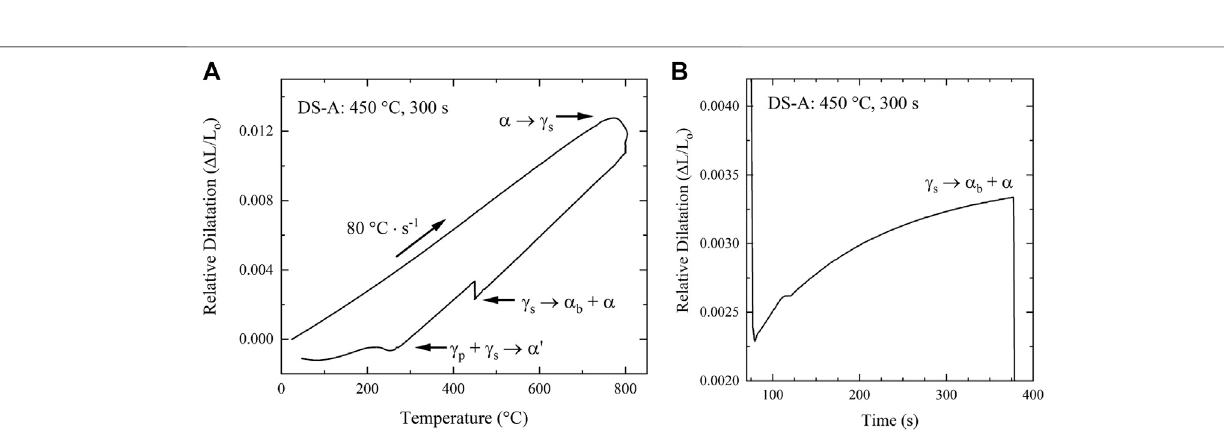
Frontiers in Materials |